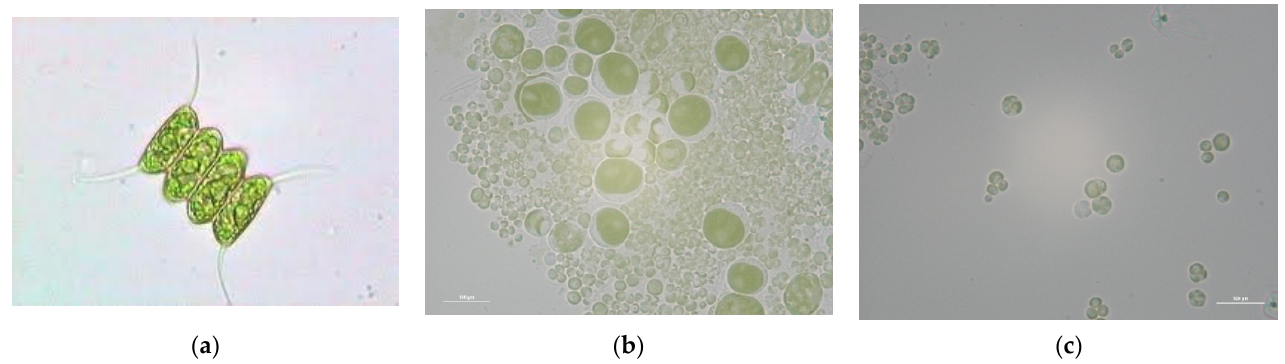
Figure 3. Micrographs by optical microscopy of ( a ) Scenedesmus sp. to magnifications of 200 µm, ( b ) Charca Brovales consortium to magnifications of 100 µm, and ( c ) Arrocampo to magnifications of 100 µm.